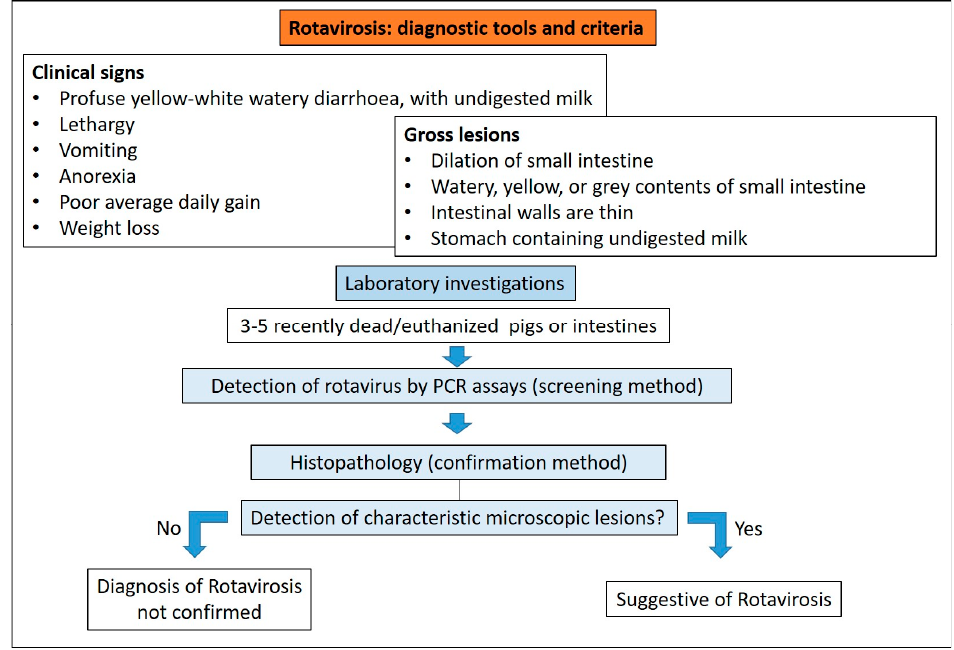
Figure 16 Figure 16. Diagnostic algorithm for the diagnosis of rotavirosis in